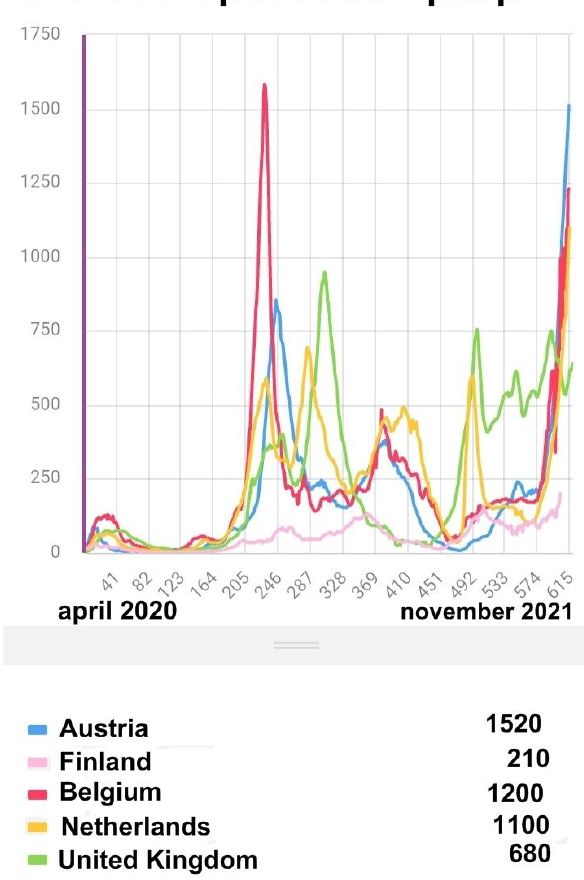
Figure 12. The fourth wave of the pandemic COVID -19 in Europe: infections per million following national vaccination programs. Blue line – Austria (68% of the vaccinated population); pink – Finland (75% of the vaccinated population); red line – Belgium (75% of the vaccinated population); yellow line – Netherlands (76% of the vaccinated population); green line – Great Britain (74% of the vaccinated population). The infections per million of population